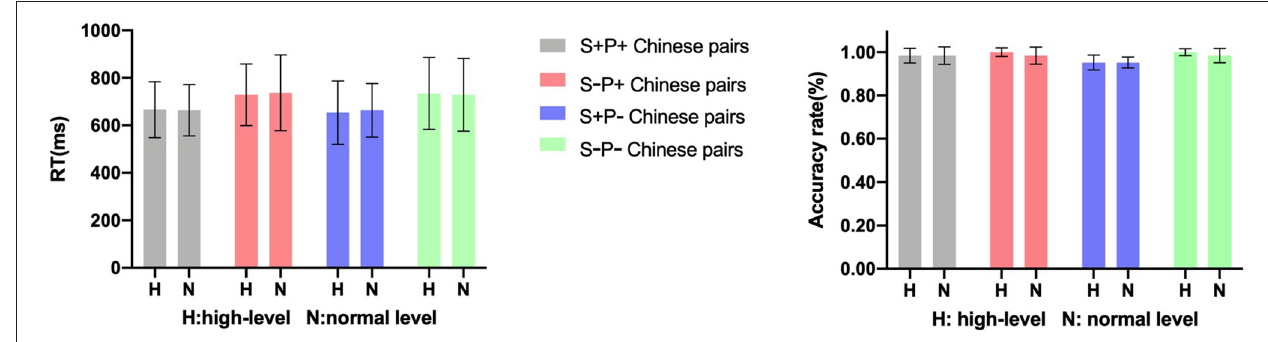
FIGURE 1 | Mean RT and accuracy rates for the two groups in four factors (error bars indicate standard